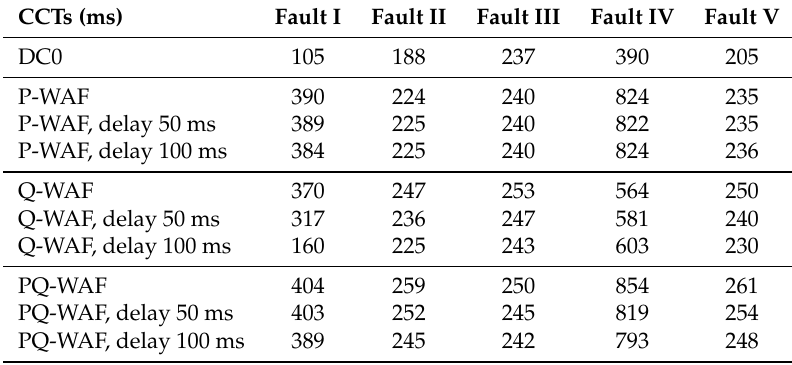
Table 11. Case A. CCT. Effect of communication